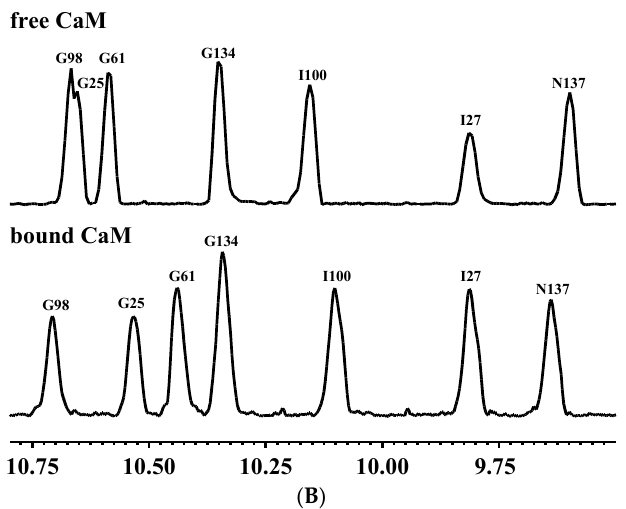
Figure 2. Stoichiometric ratio measurements of CaM/CaNp complex by DLS and NMR. ( A ) Dynamic Light Scattering (DLS) measurements on standard proteins and CaM/CaNp complex. A double logarithmic calibration curve of R H versus M r , shown in black line was generated using DLS measurements of standard proteins including BSA (R H 6.75 nm, M r 67 kDa), CaM (R H 2.44 nm, M r 16.7 kDa), lysozyme (R H 2.20 nm, M r 14.7 kDa), and ubiquitin (R H 1.7 nm, M r 8.4 kDa), which were shown in black circles. Hydrodynamic radius (R H ) distribution of CaM/CaNp complex was determined by DLS. Nine DLS measurements were performed for CaM/CaNp complex, and the average R H for CaM/CaNp complex is 2.61 nm (inset). The M r of CaM/CaNp was then estimated to 17.2 kDa by linear intrapolation by red dash lines. ( B ) 1D NMR spectral linewidth measurements on free CaM and CaM/CaNp complex. The average half-width of NH resonance of G61, G134, I100 I27, and N137 for the bound CaM is 15.5 Hz; the average half-width of those NH resonances for the free CaM is 16.0 Hz. The specific activity of CaN increased to 0.83 µM/h when equivalent concentration of CaM was added to the reaction. However, the specific activity of CaN was 0.24 µM/h when CaM was pretreated with equivalent concentration of CaNp. Apparently, CaM loses most of its ability to activate CaN in the presence of CaNp. Our data indicated that both CaN and CaNp competed for the binding to CaM, however, the binding of CaNp is much stronger than CaN to CaM.